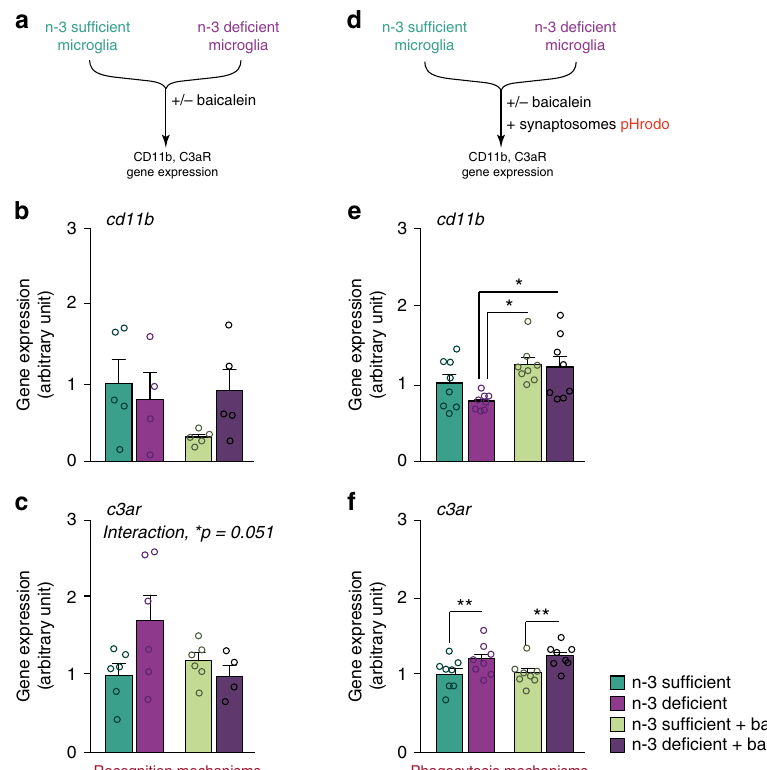
Fig. 7 The 12/15-LOX/12-HETE signaling pathway controls gene expression of the complement pathway. a Experimental setup. b , c Quanti fi cation of cd11b and c3ar mRNA expression in freshly sorted n-3 de fi cient and n-3 suf fi cient microglia, treated with baicalein or its vehicle. Means ± SEM; n = 4 – 6 per group. Two-way ANOVA: cd11b : diet effect, F (1,15) = 0.57, p = 0.46; treatment effect, F (1,15) = 1.37, p = 0.26; interaction, F (1,15) = 2.48, p = 0.14; c3ar : diet effect, F (1,18) = 1.36, p = 0.26; treatment effect, F (1,18) = 1.52, p = 0.23; interaction, F (1,18) = 4.36, * p = 0.051. d Experimental setup. e , f Quanti fi cation of cd11b and c3ar mRNA expression in freshly sorted n-3 de fi cient and n-3 suf fi cient microglia, exposed to synaptosomes for 2 h and treated with baicalein or its vehicle. Means ± SEM; n = 8 per group. Two-way ANOVA followed by Bonferroni post hoc test: cd11b : diet effect, F (1,28) = 0.16, p = 0.19; treatment effect, F(1,28) = 0.92, ** p = 0.0028; interaction, F (1,28) = 0.072, p = 0.36; n-3 de fi cient + vehicle vs n-3 de fi cient + baicalein, * p = 0.014; n-3 de fi cient + vehicle vs n-3 de fi cient + baicalein, * p = 0.029; c3ar : diet effect, F (1,28) = 0.35, ** p = 0.0034; treatment effect, F (1,28)